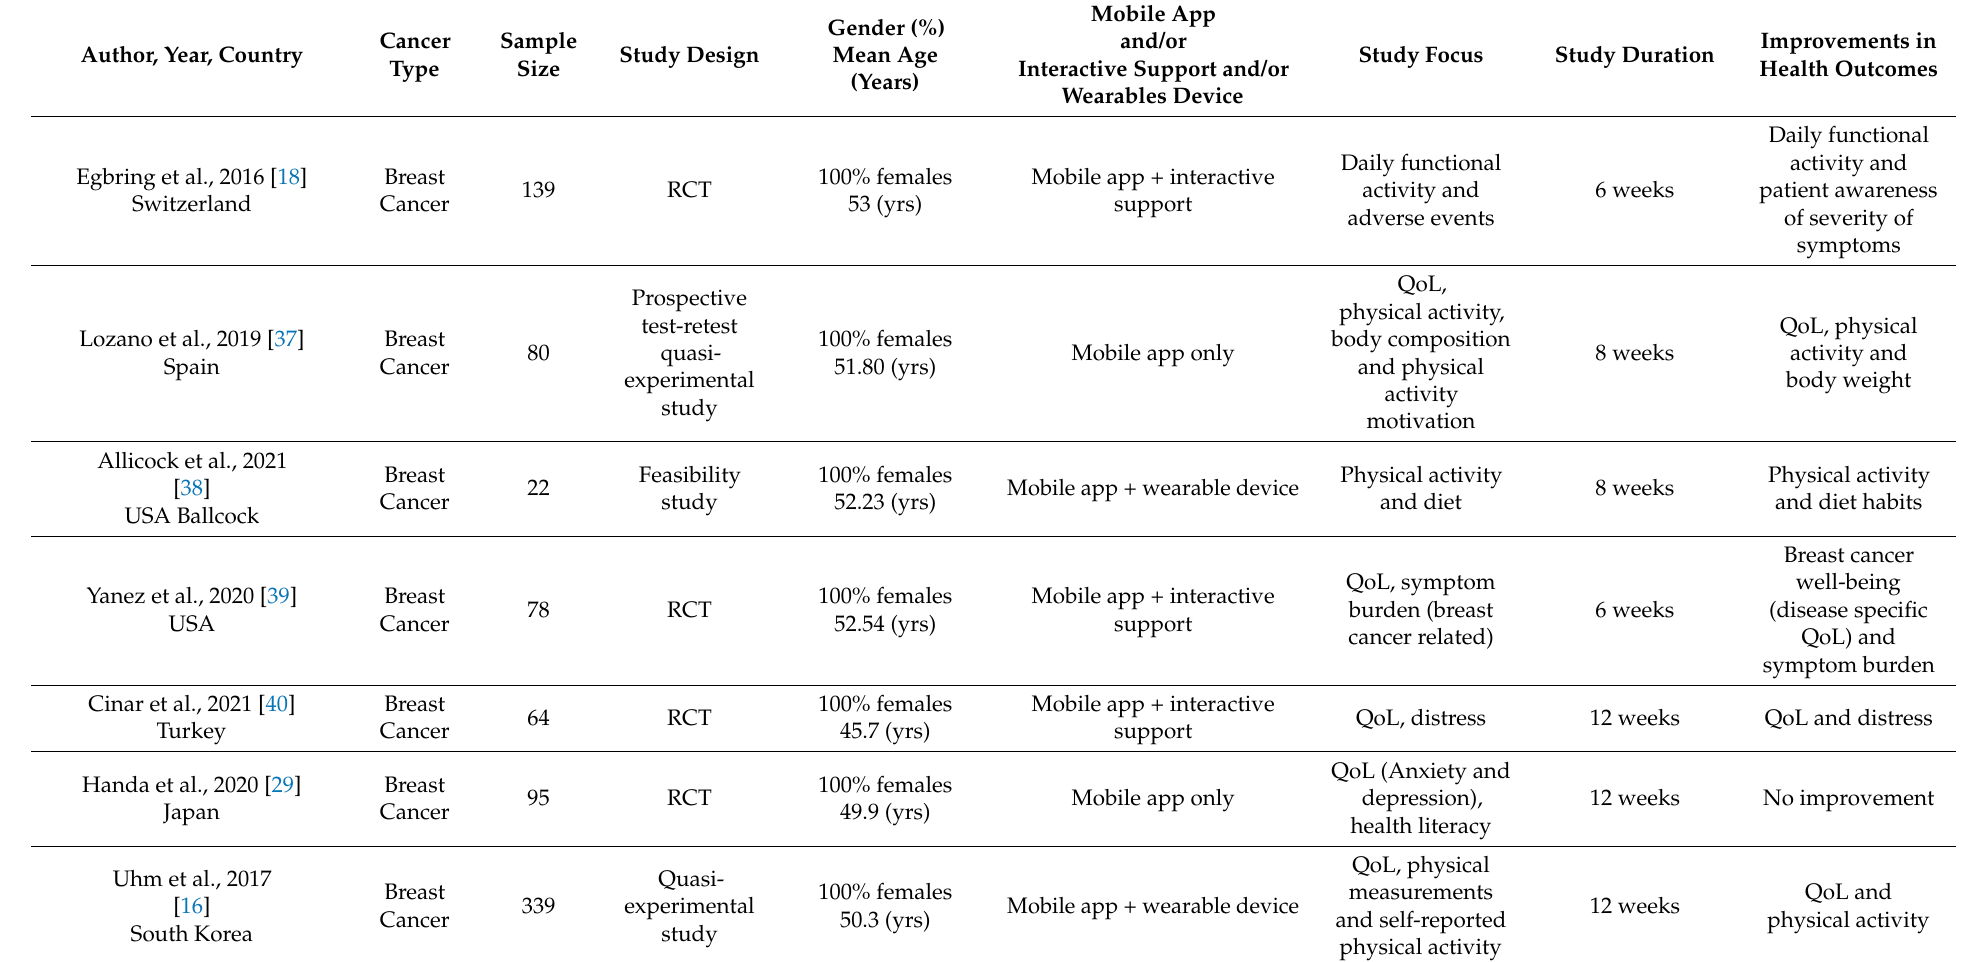
Table 1. Characteristics of included studies and mobile-based